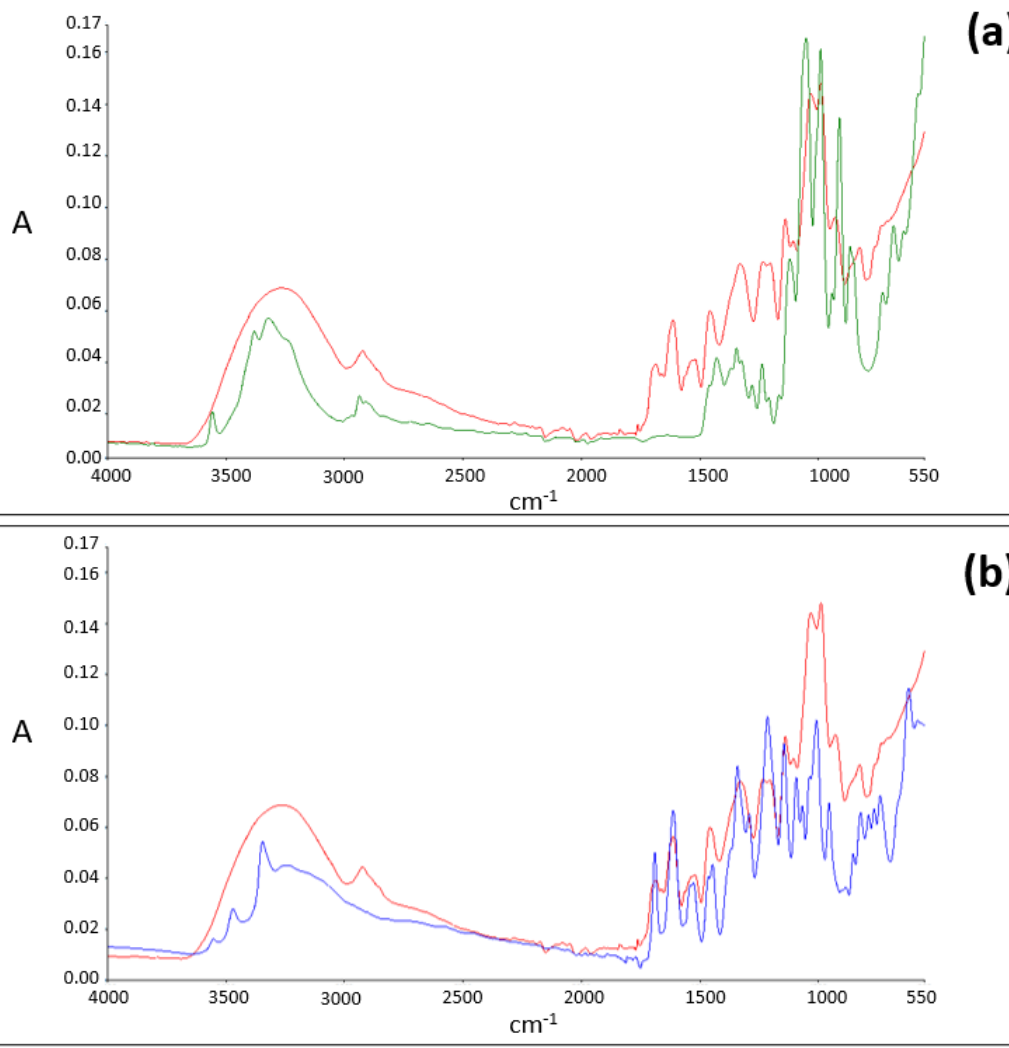
Figure 3. ( a ) ATR-FTIR spectra of sucrose (in green) and of the EGCG–sucrose complex (in red). ( b ) ATR-FTIR spectra of EGCG (in blue) and of the EGCG–sucrose complex (in red).